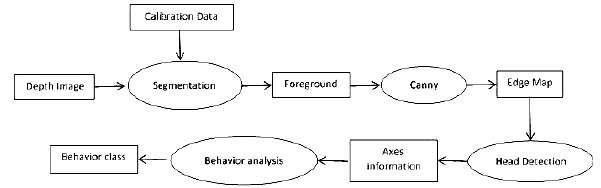
Figure 7: Diagrammatic schema from [22].